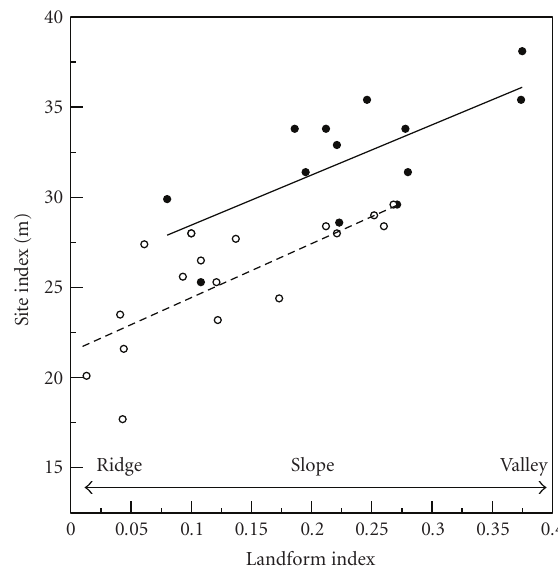
Figure 2: Comparison of linear models for predicting site index from landform index for northern red oak (open circles) and yellow-poplar (closed circles) in the Southern Appalachian Moun- tains of North Carolina, USA. Classes of landform associated with values of the landform index are shown above the x